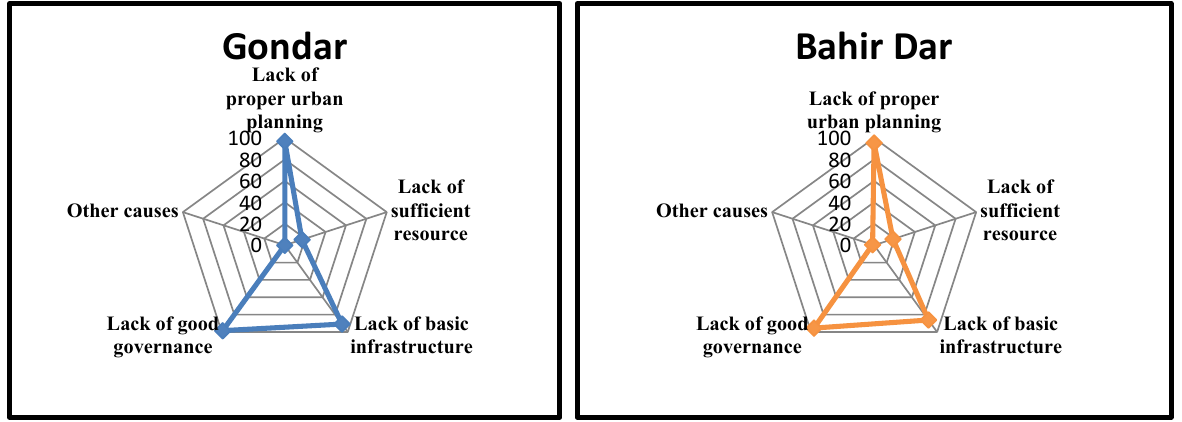
Figure 3. Factors that influence building urban resilience. Source: Field survey, 2021.